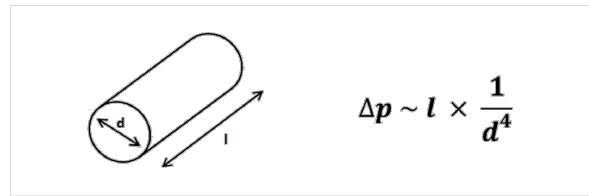
Figure 6: Photograph of the operating flow reactor, irradiated with white LEDs, filled with a solution of methylene blue (1.0 mM), a cyclo- hexene (0.1 M), and oxygen at 30 bar with a flow rate of 1.0 mL min − 1 in an FEP tubing reactor (0.79 mm inner